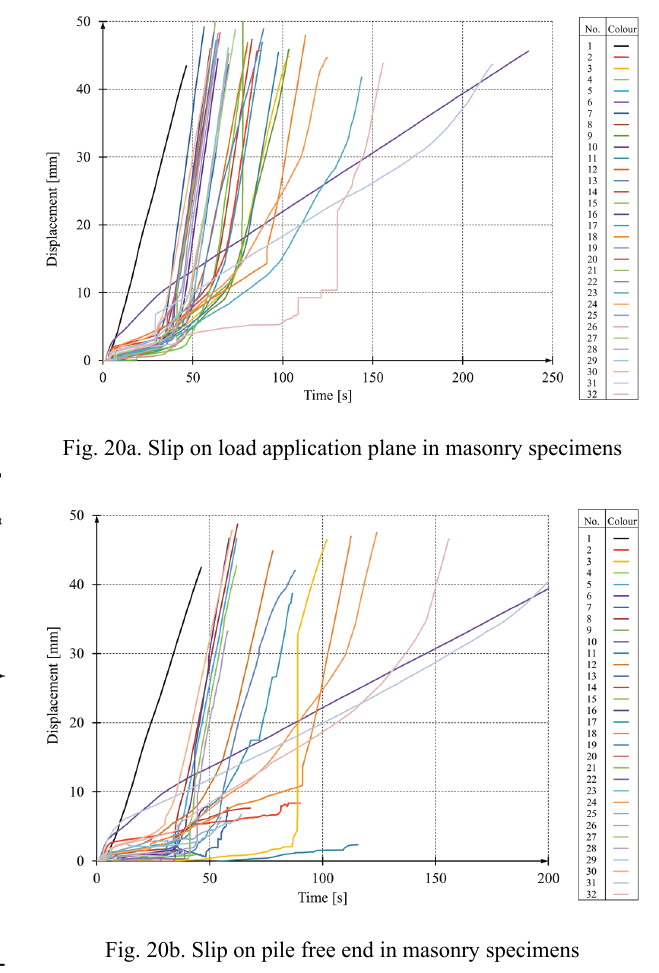
Fig. 20b. Slip on pile free end in masonry